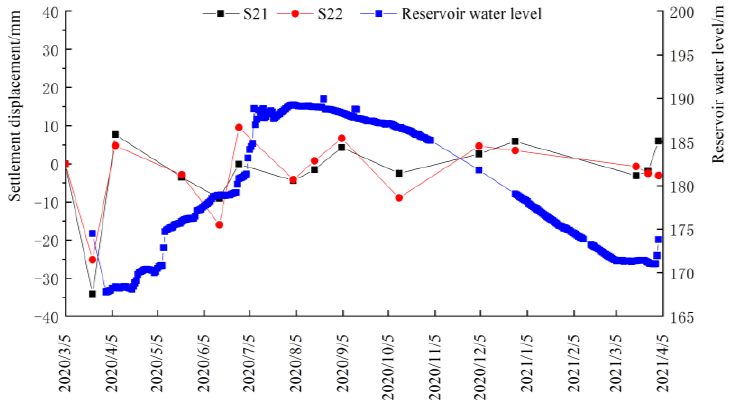
Figure 11. 2 # section settlement displacement duration curve (downward is +, upward is − ).